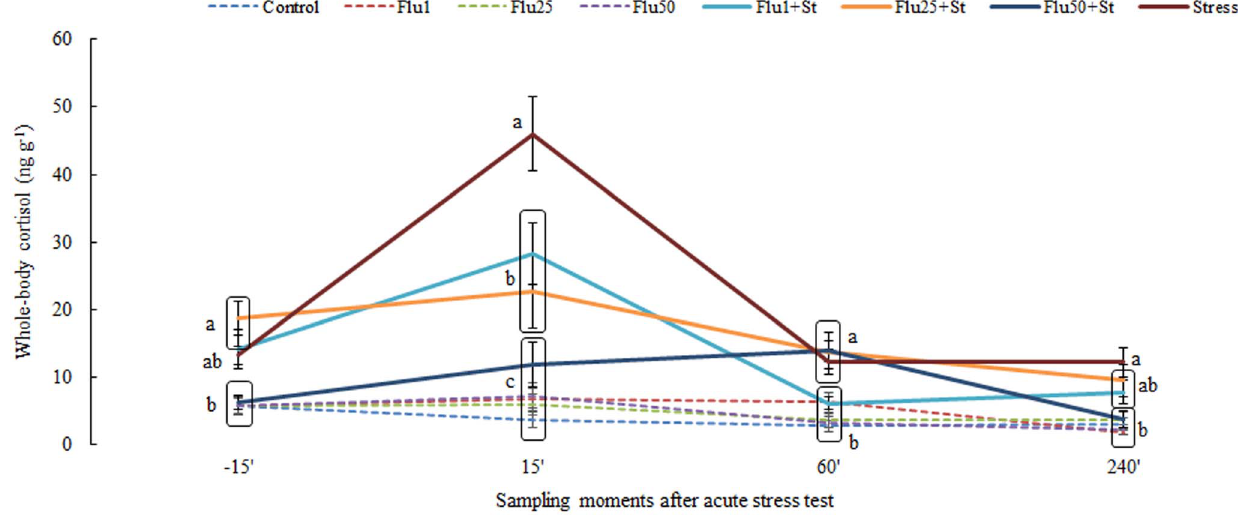
Figure 3. Whole-body cortisol concentrations in zebrafish to fluoxetine followed by an acute stress test and respective controls. The values are expressed as the mean 6 standard error of mean. Different small letters indicate significant group differences in each sampling time.